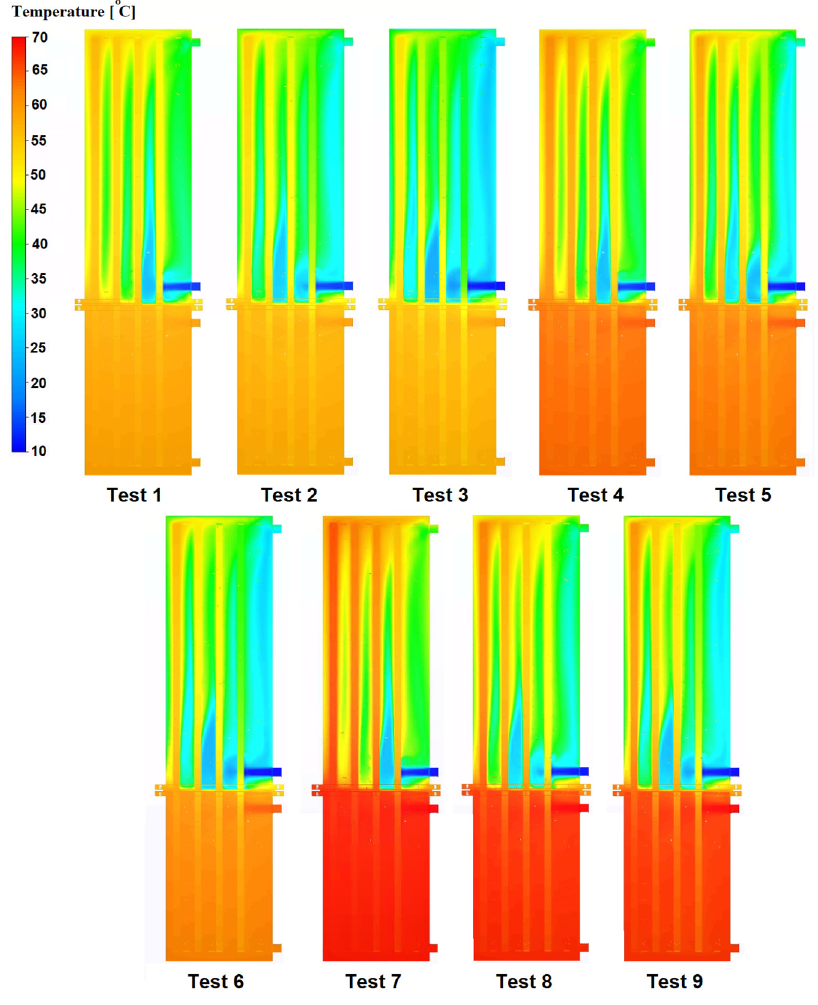
Figure 9. 2D section plane.